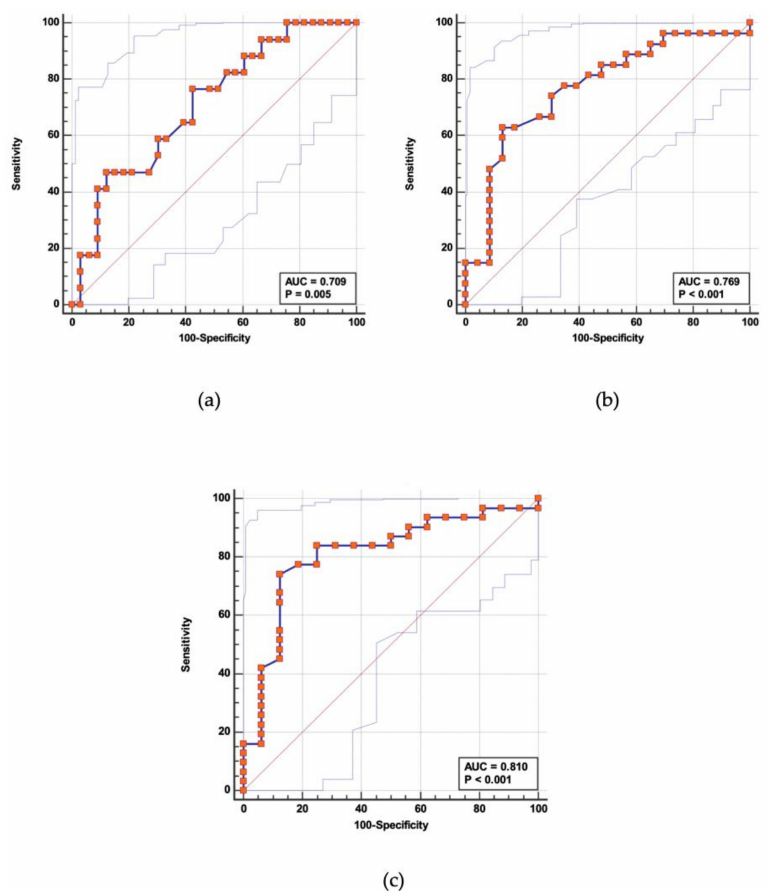
Figure 2. The receiver operating characteristic (ROC) analysis to set the optimal cut-off value of vitamin D to assess the ( a ) clinical activity, ( b ) endoscopic activity, and ( c ) histologic activity. AUC: area under the